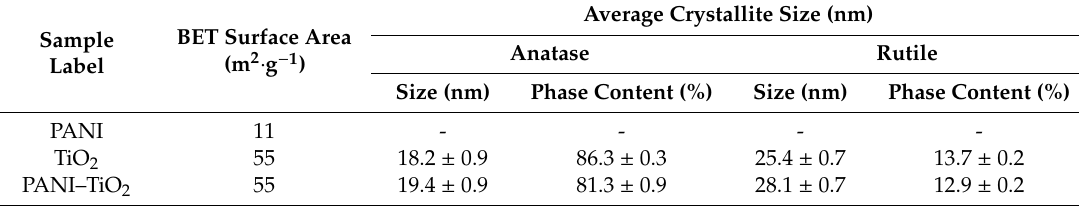
Figure 2. XRD patterns of PANI, TiO 2 , and PANI–TiO 2. Table 1. Crystalline structure and BET surface area of TiO 2 , PANI, and PANI–TiO 2